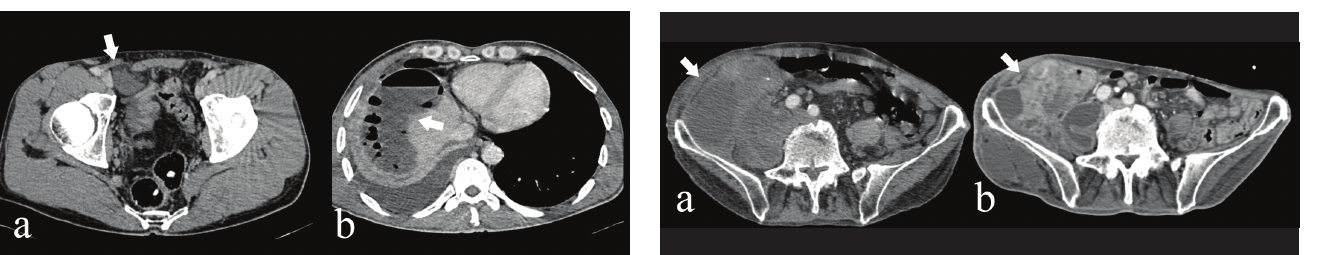
Figure 2 - Abscess (arrow) in right lower quadrant on pre- interventional CT (a) and recurrent abscess formation (arrow) in catheter trace on post-interventional CT (b) 6 months after percutaneous drainage in 51-year-old woman with perforated appendicitis.